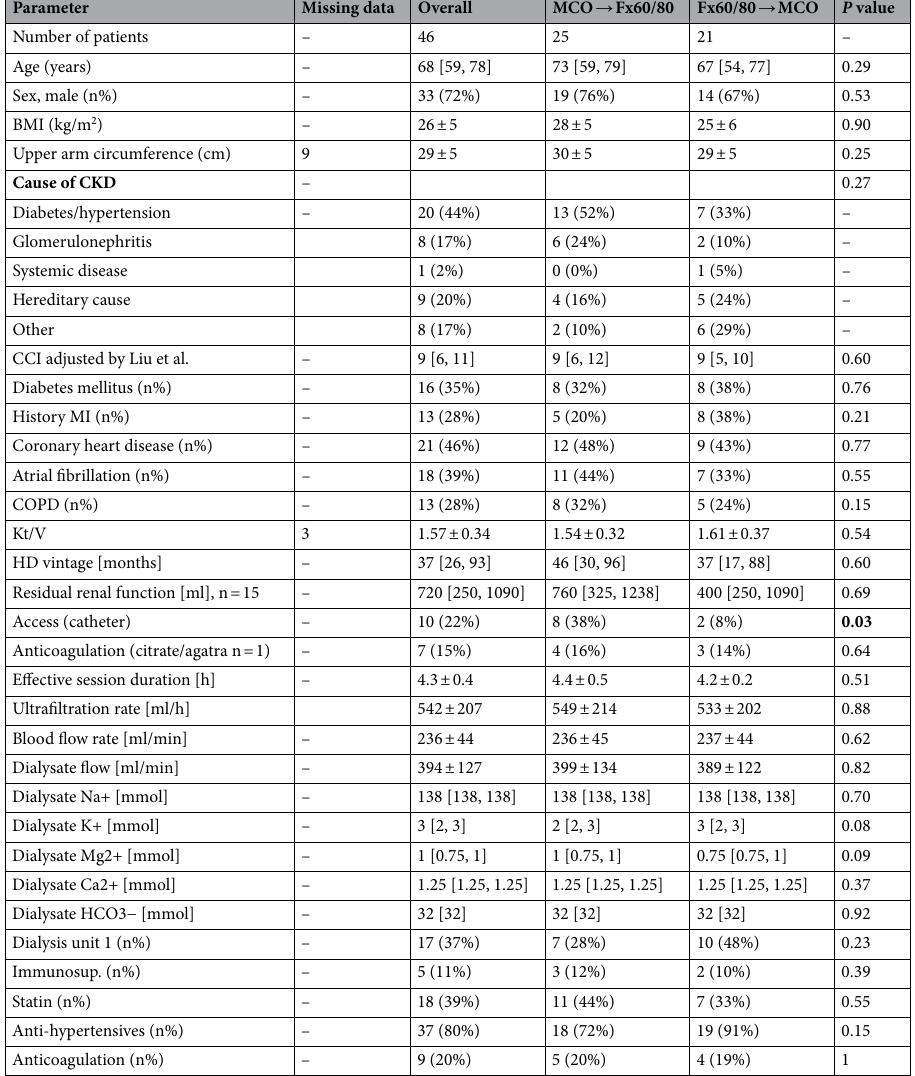
Table 1. Baseline characteristics of the intention to treat population. We report mean ± SD, median and interquartile range (IQR) or counts and percent of subsets according to distribution of variables. Kt / V was calculated according to Daugirdas = − ln((Post BUN/Pre BUN) − (0.008 × Dialysis duration)) + (4 − 3.5 × (Post BUN/Pre BUN)) × (UF/Weight). ANOVA, Mann–Whitney-U-test or cross tables and Chi-Square were used for statistical comparisons of subgroups. P < 0.05 was considered statistically significant. Significant values are in [bold]. BMI = body mass index; Charlson Comorbidity Index adjusted by Liu et al. 40 ; COPD = chronic obstructive pulmonary disease; Immunosup. = Immunosuppression; MI = myocardial